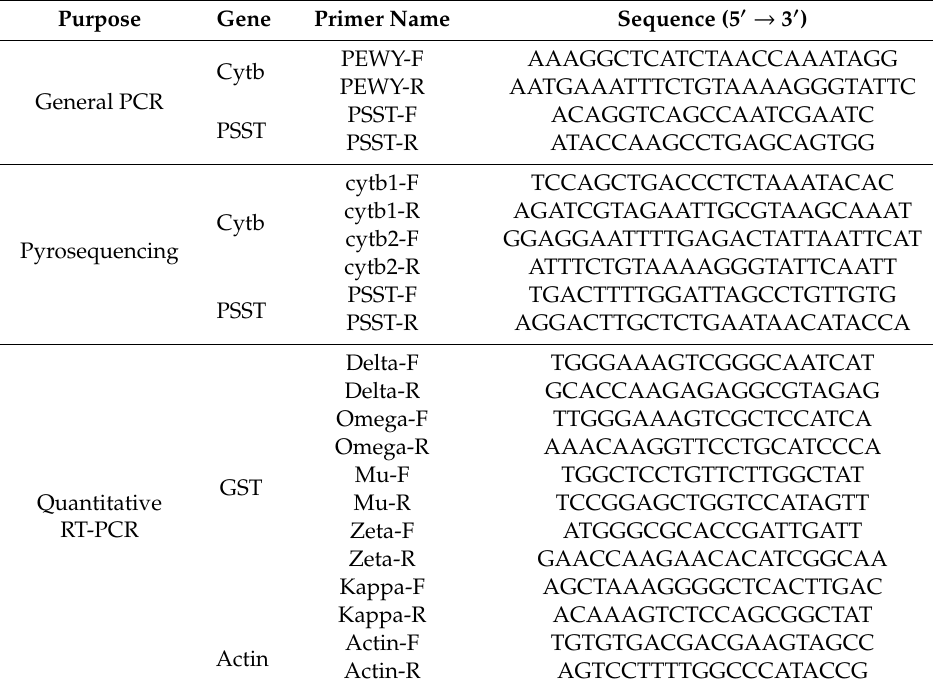
Table 1. List of primers used in this